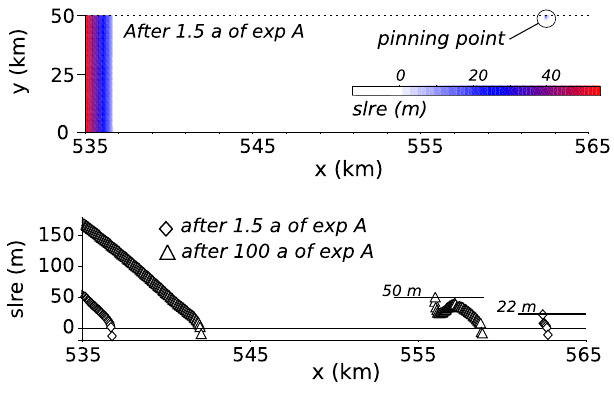
Fig. 12. Difference between normal stress and sea pressure in terms of sea level rise equivalent (slre) at the beginning of experiment B (starting similarly to experiment A), at t = 1.5 and 100 a. (top) 2-D view around the grounding line areas. (bottom) Along the flowline y = 50 km, only the grounded points are represented. Horizontal lines represent the sea level rise to impose on the model to release the pinning point (Experiment